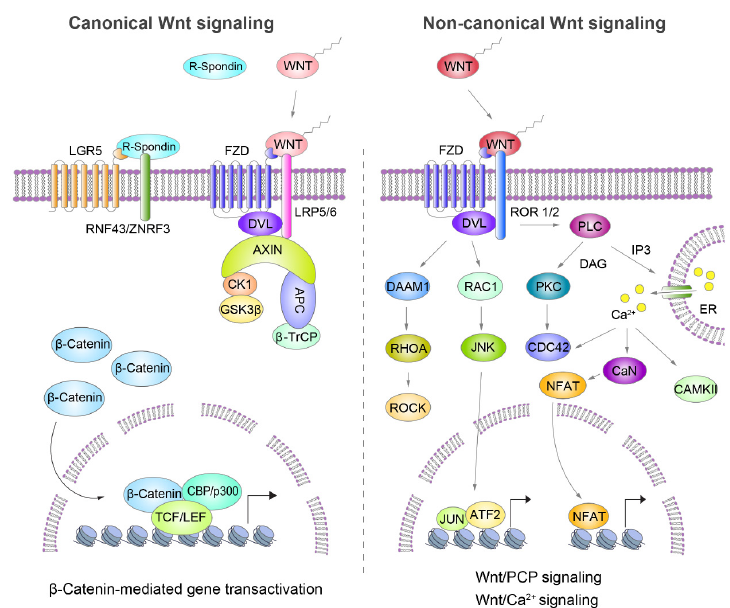
Figure 1. General view of canonical and non-canonical Wnt signaling. The switch of the canonical Wnt/ β -catenin signaling pathway depends on the subcellular location of β -catenin. The stability of β -catenin is controlled by the destruction complex, consisting of AXIN, APC, CK1, and GSK3. In the absence of WNT ligands, cytoplasmic β -catenin is first phosphorylated by CK1 at Ser45 residue, followed by GSK3 phosphorylation at the Thr41, Ser37, and Ser33 residues. Next, the phosphorylated motif of β -catenin acts as a docking site for β TrCP, which induces the final ubiquitin-mediated degradation of β -catenin (Wnt off). When WNT ligands bind to Frizzled receptors (FZDs) and low density lipoprotein receptor-related protein co-receptor 5/6 (LRP 5/6), the destruction complex is recruited to the plasma membrane, triggering the translocation of β -catenin into the nucleus and activating its downstream target genes via binding directly to the TCF/LEF transcription factor family (Wnt on). Wnt/PCP signaling involves the triggering of a cascade that contains small GTPases RHOA (transforming protein RhoA) and Ras-related C3 botulinum toxin substrate 1 (RAC1), activating Rho- associated protein kinases (ROCKs) and JUN N-terminal kinases, respectively. Wnt/Ca 2+ signaling involves the activation of phospholipase C, which in turn triggers the release of Ca 2+ from intracellular stores and the activation of effectors such as calcium- or calmodulin-dependent protein kinase II, protein kinase C, and calcineurin (CaN). Next, CaN activates the nuclear factor of activated T cells, activating the transcription of downstream target